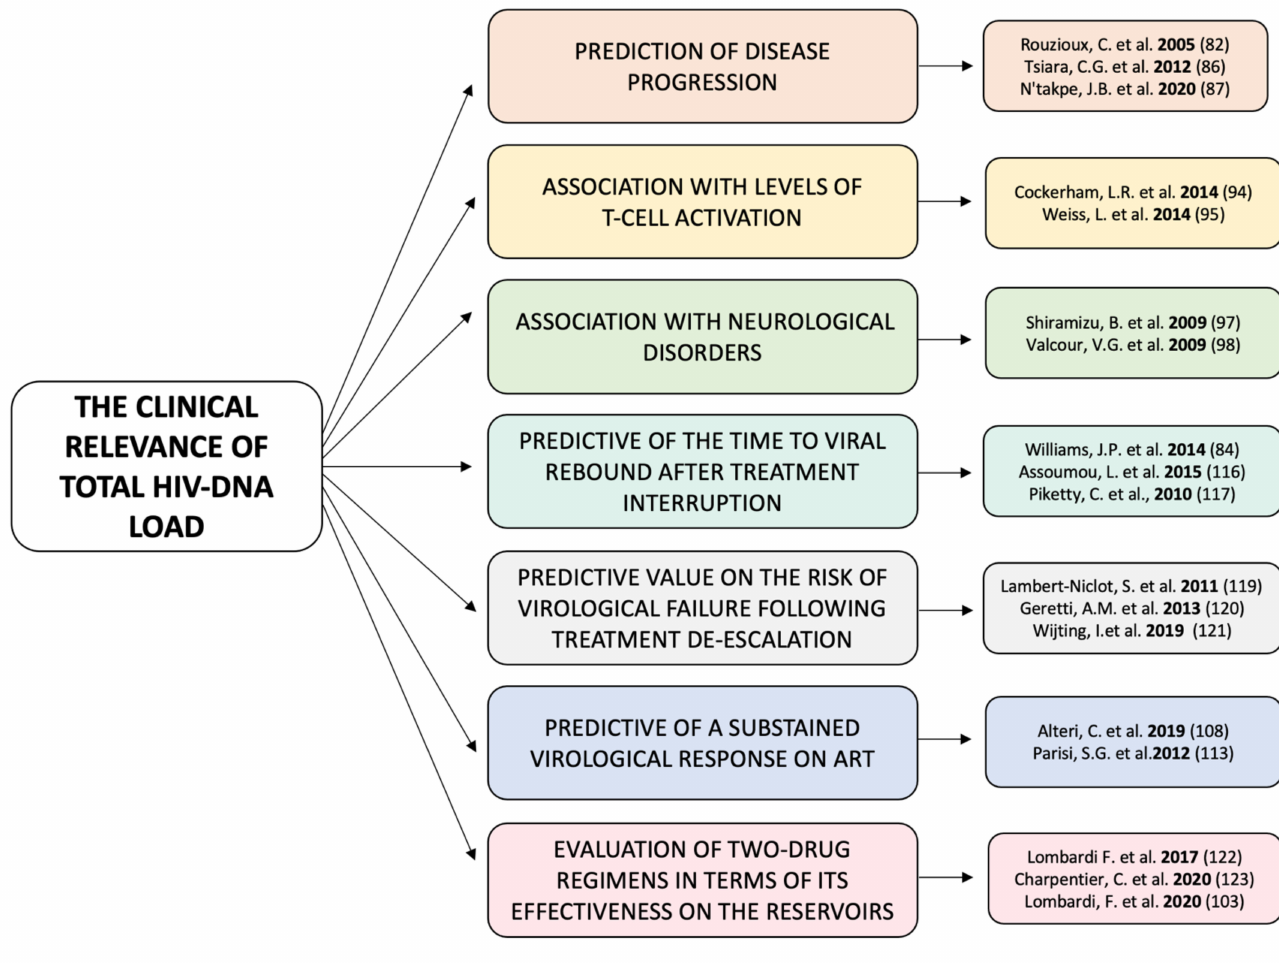
Figure 2. Main studies supporting the clinical role of total